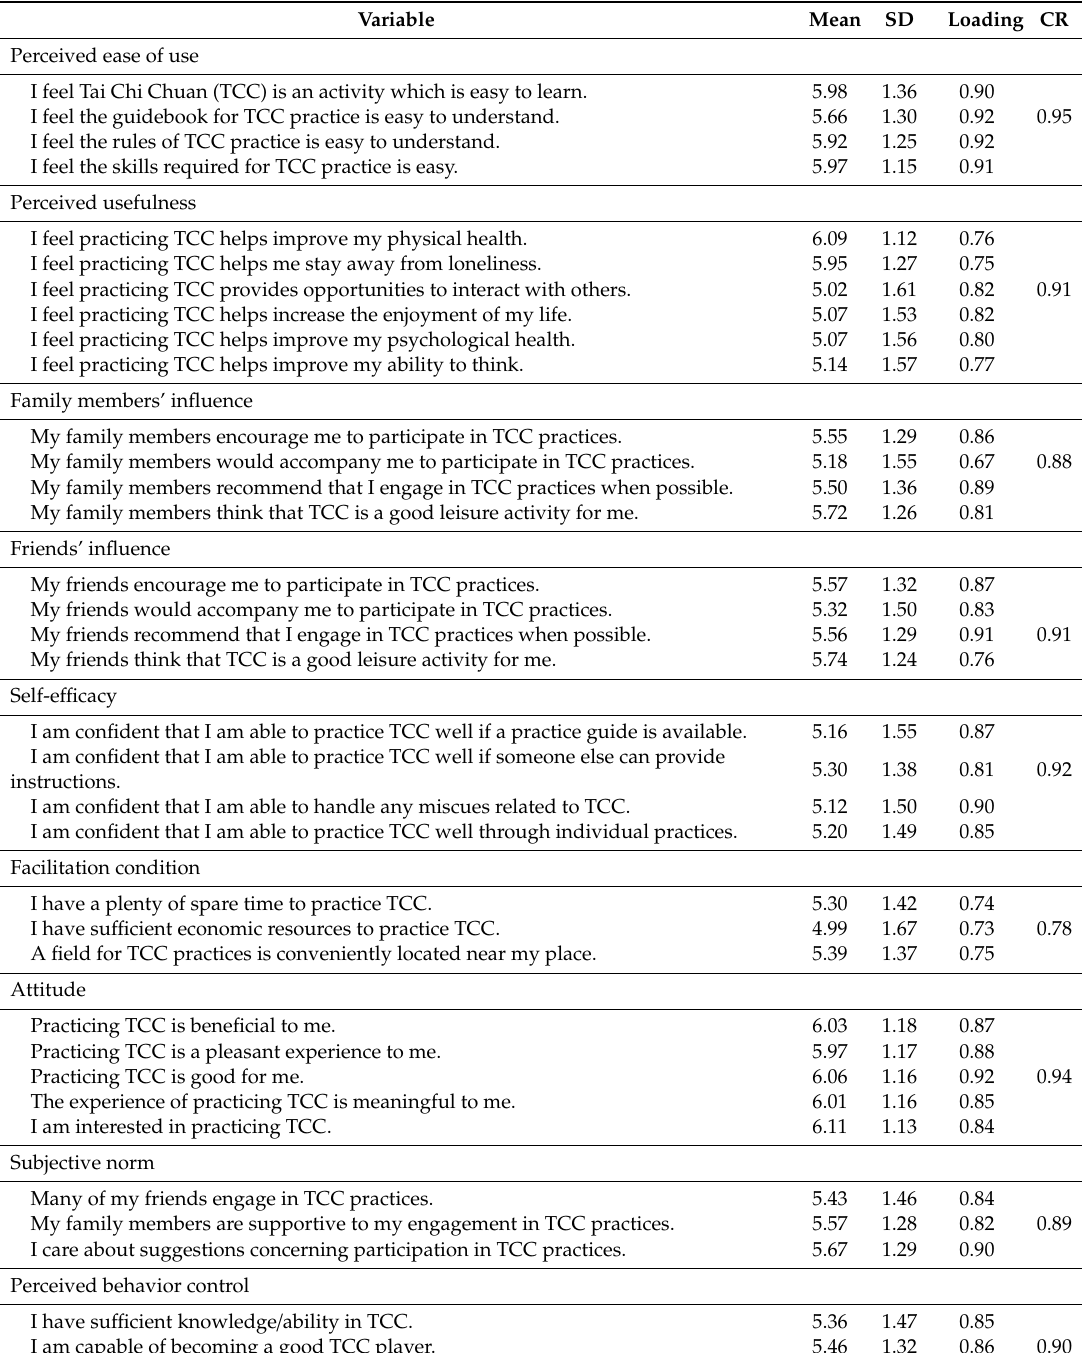
Table 1. Descriptive statistics (mean and standard deviation (SD), N =